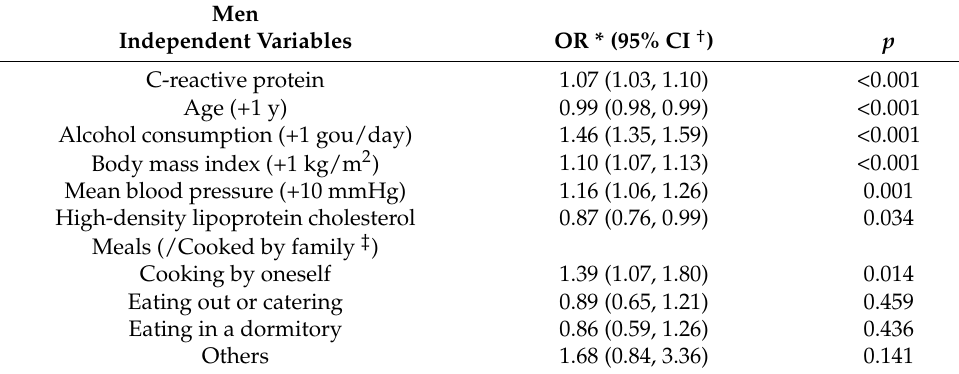
Table 2. Number of person-years studied and incidence rate, grouped according to age at study entry. Data Items Men Number of subjects examined 7830 Number of subjects who developed liver damage 800 (%) 10.2 Total person-years of observation 23,215 Incidence rate per 1000 person years 34.5 Mean observed years per person 2.96